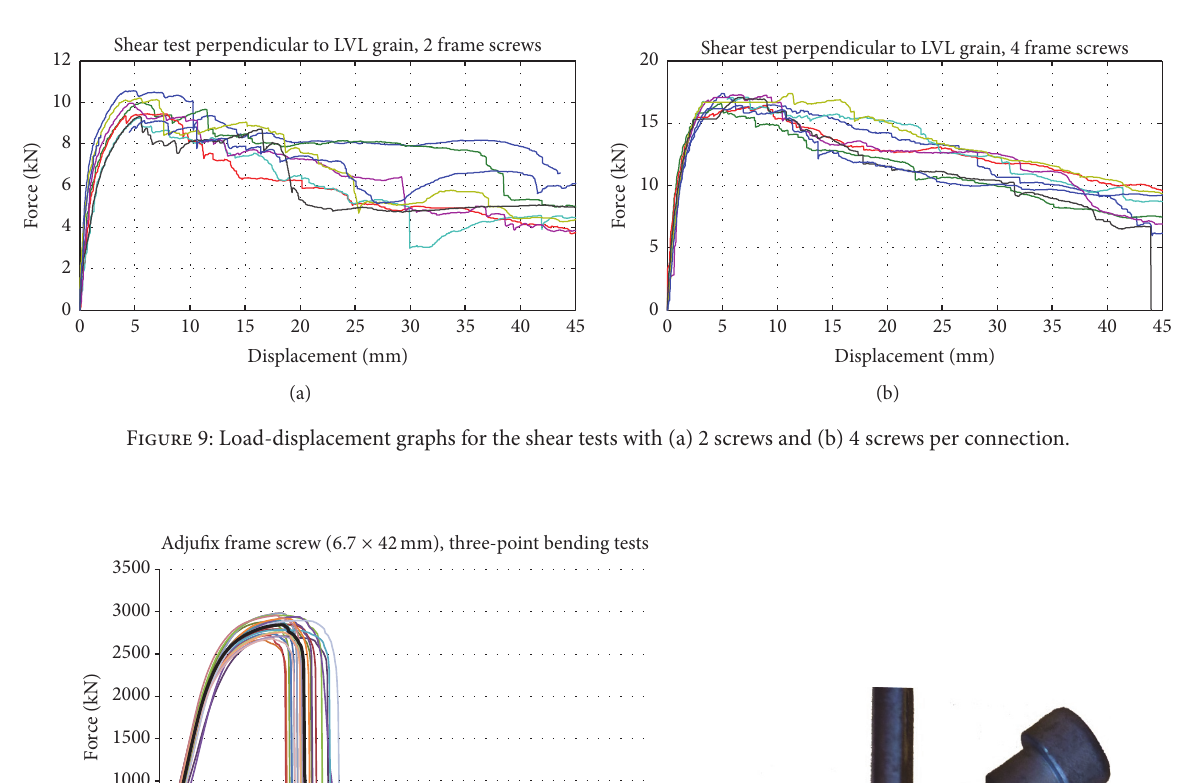
Shear test perpendicular to LVL grain, 2 frame screws